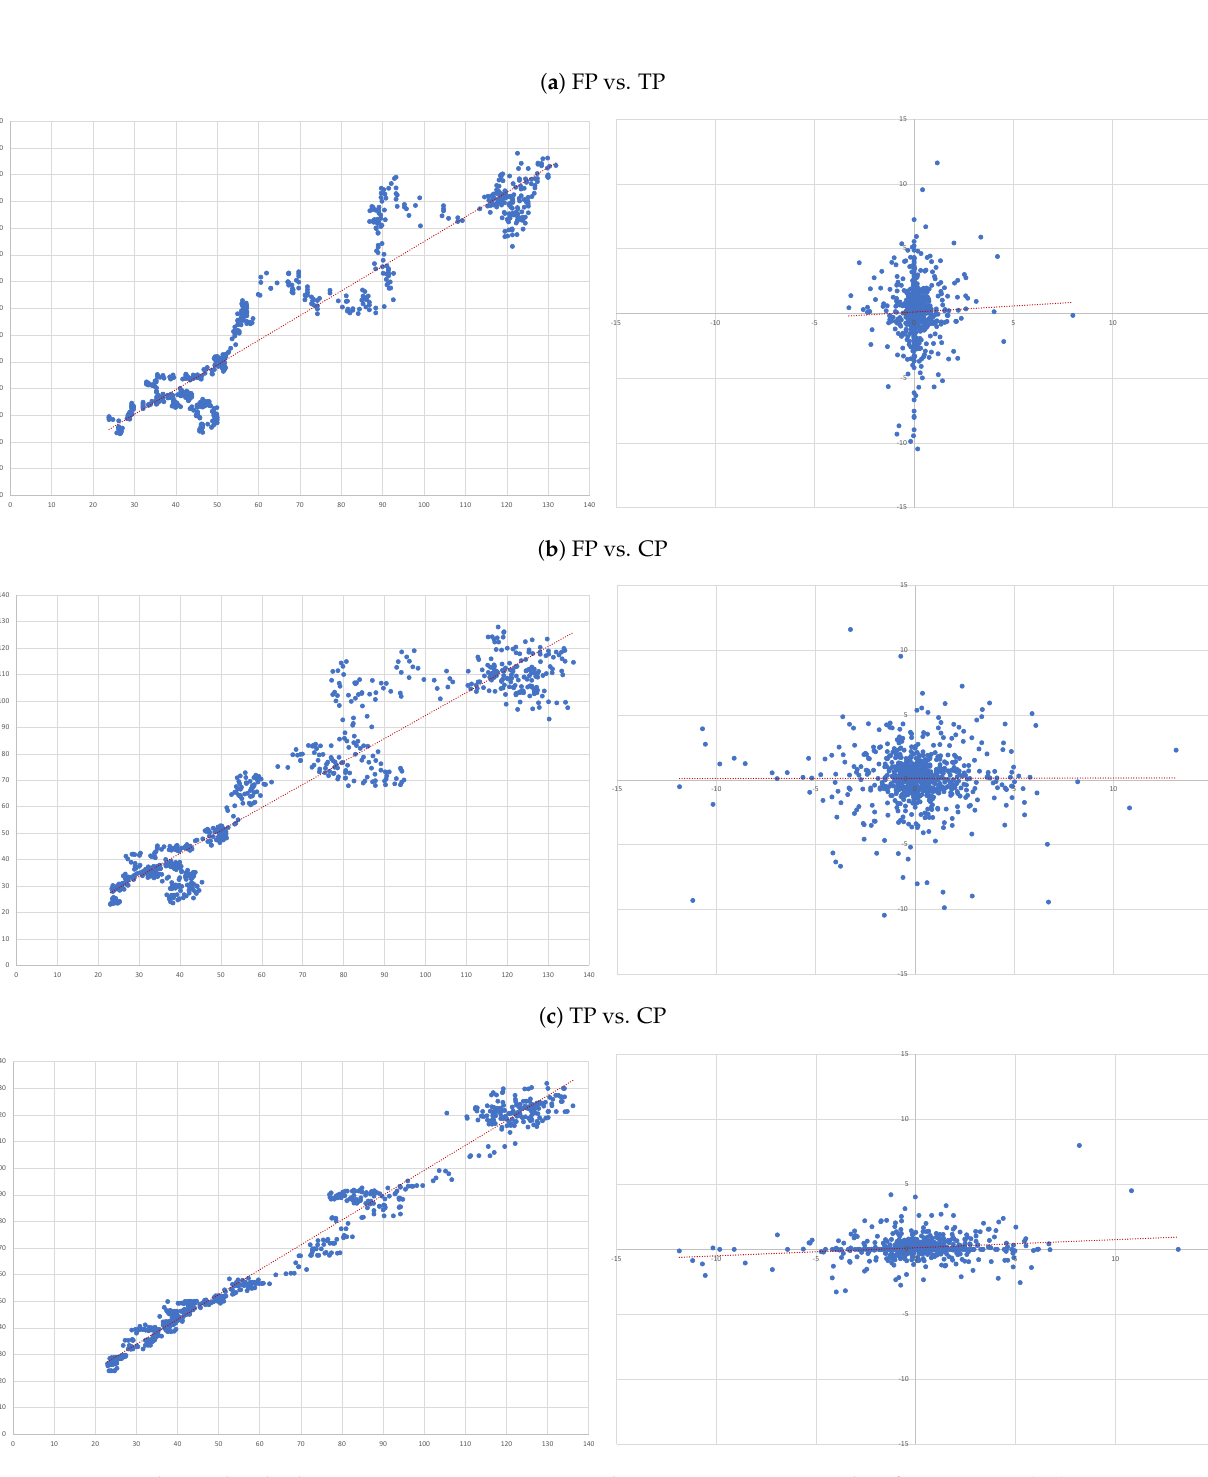
Figure A4. Essilor. Individual time series regressions using three price series on Essilor: future prices (FP), target prices (TP), and capitalised prices (CP) forecasts. On the left-hand-side are images of level regressions and on the right-hand-side are regressions in